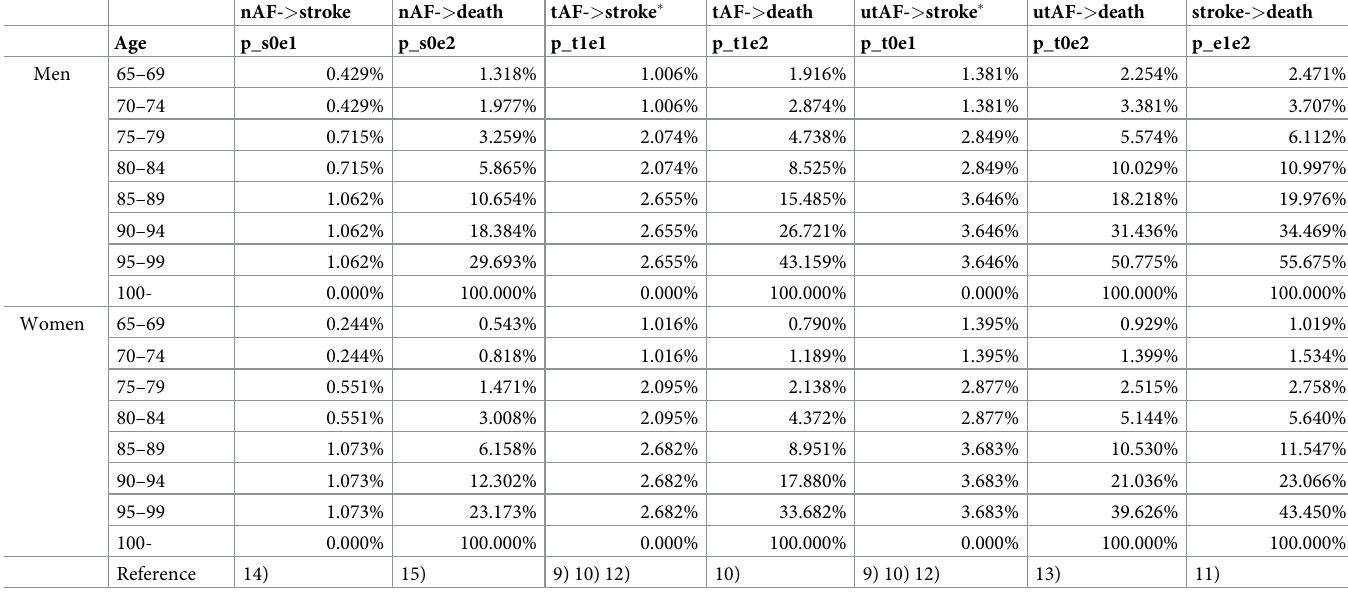
Table 1. Estimated annual transition probability between each state.